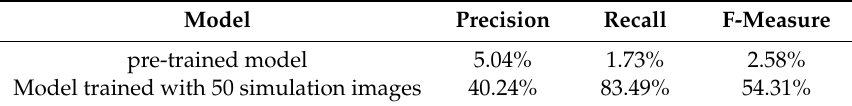
Table 1. The results from different models.